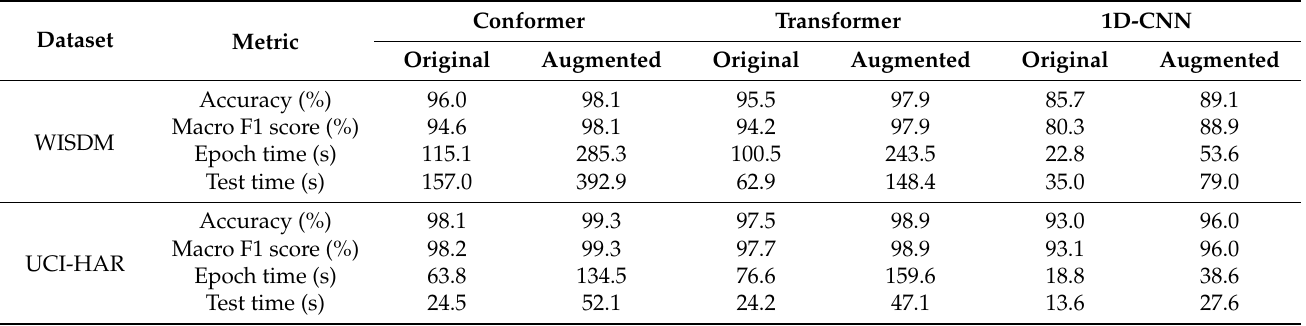
Table 2. Performance of proposed model before and after data